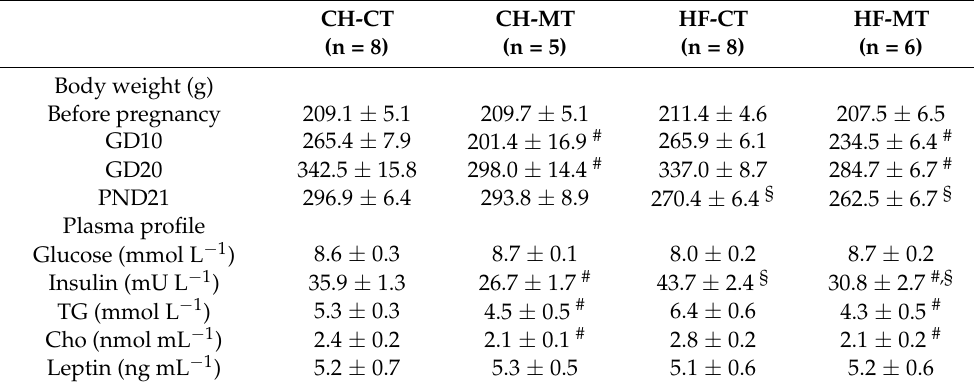
Table 2. Maternal body weight during gestation and lactation and plasma profile at